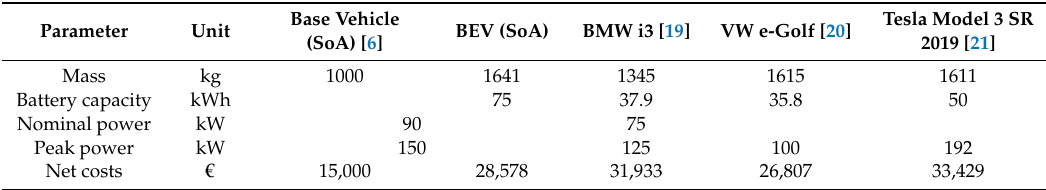
Table 1. Parameter of base vehicle and BEV compared to available BEVs for state of the art (SoA). Parameter